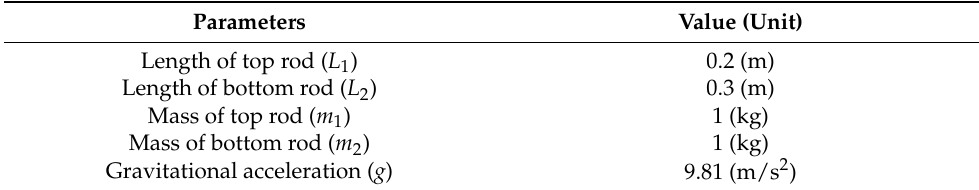
Parameters Value (Unit)